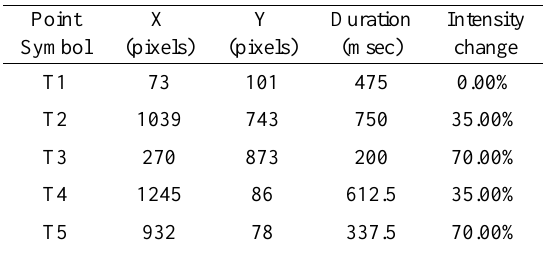
The location coordinates (in pixels) for each selected combination of duration (in msec) and background with different color intensity level expressed as changes (%) of the main cartographic